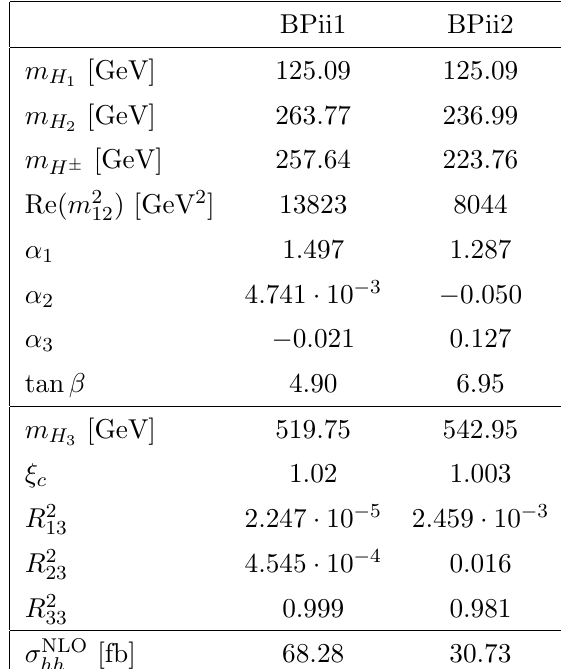
Table 4 . Line 1-8: the input parameters of the benchmark points BPii1 and BPii2. Line 9 to 13: the derived 3rd neutral Higgs boson mass, the (cid:24) c value and the CP-odd admixtures R 2 the NLO QCD gluon fusion hh production cross section at p s = 14